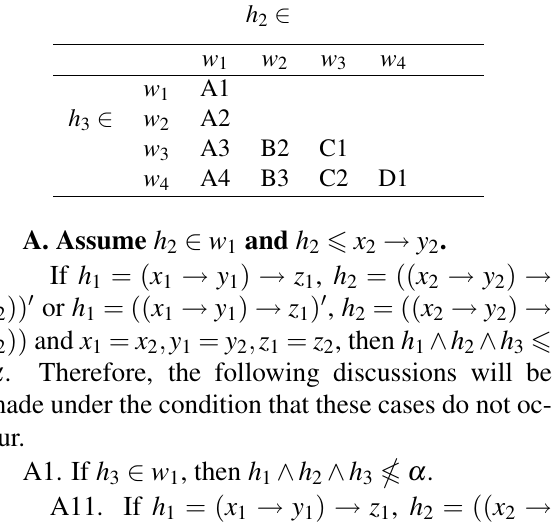
Table 3. Different Cases of Structure of D 2 α ( g ) when g = h 1 ∈